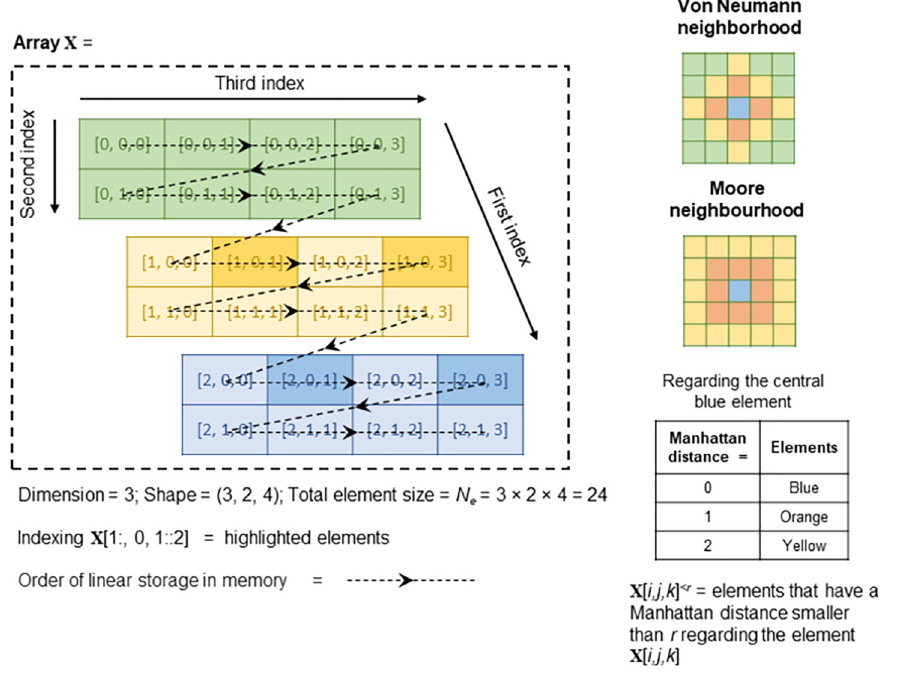
Fig 2. Array, neighbourhood and representation of neighbouring